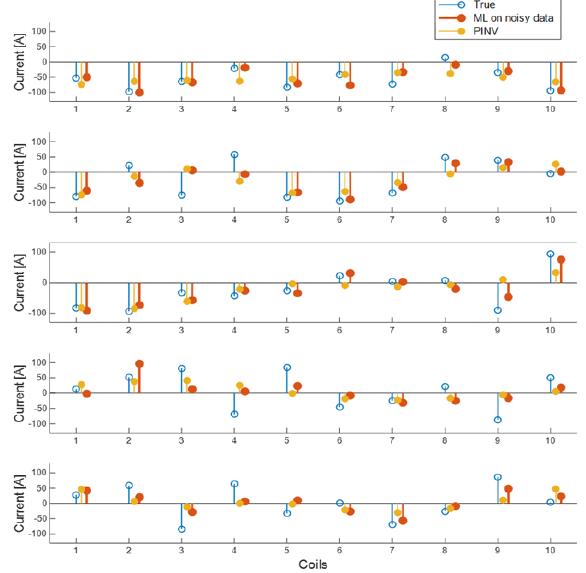
Figure 8 . Five examples of reconstructed currents in the validation data set. Blue: true currents; red: reconstructions using RRA with noisy data; and yellow: reconstructions using pseudo-inverse with six singular modes kept.